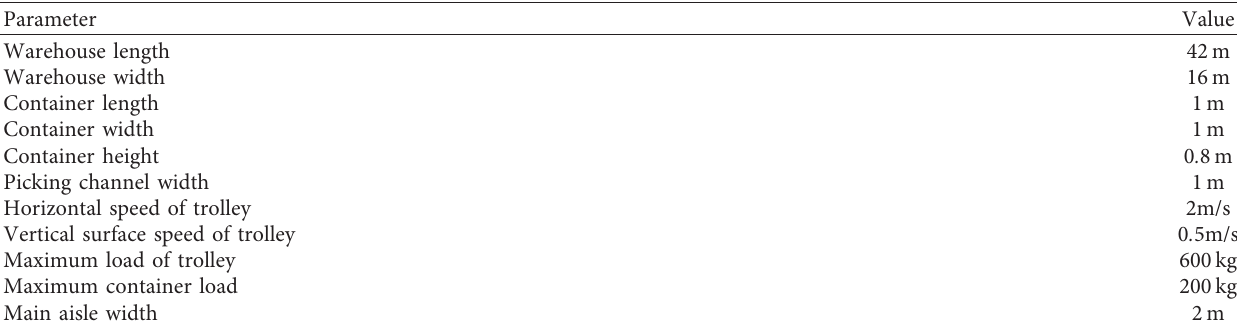
Table 2: Experimental parameter table.